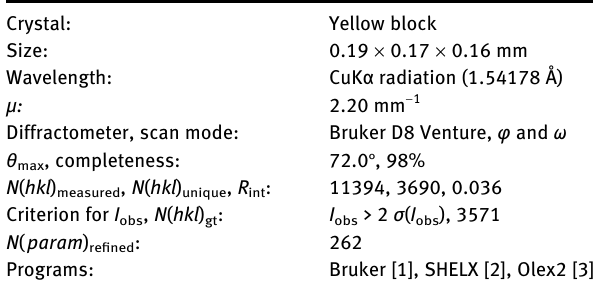
Table  : Data collection and handling. Crystal: Yellow